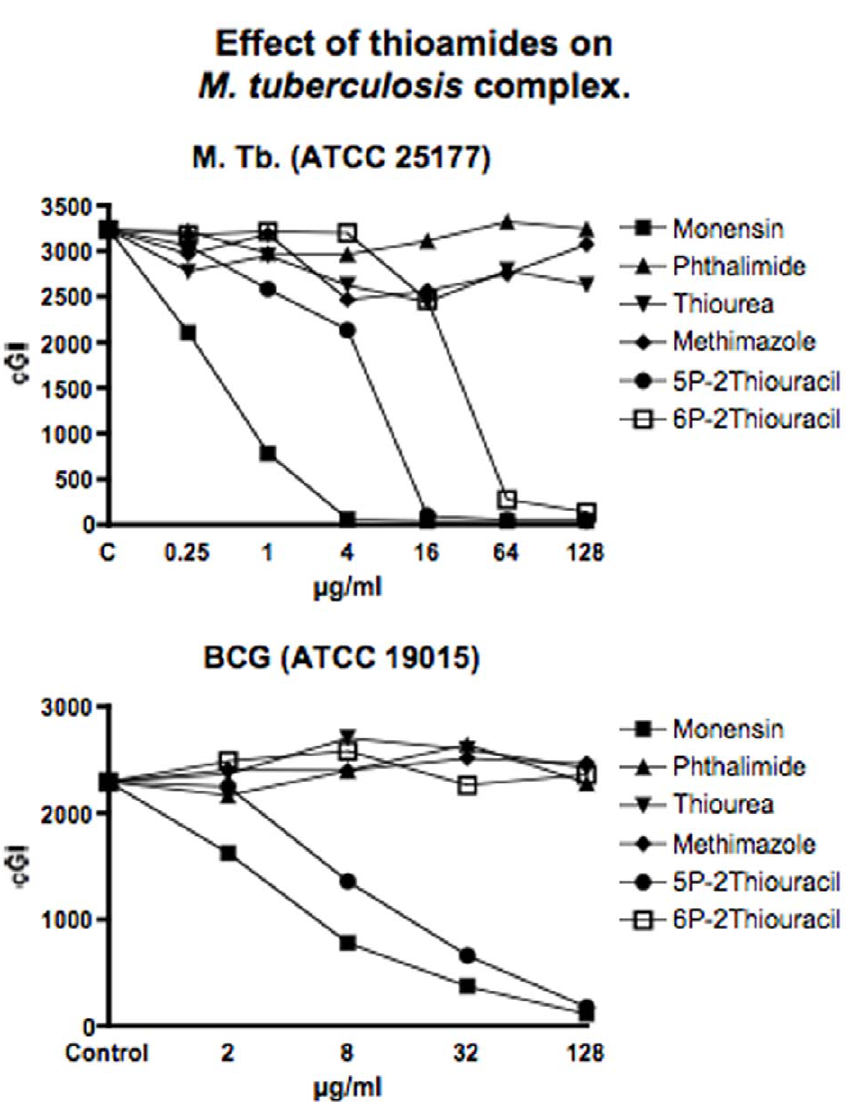
M. avium (Table 4 & Figure 3) or M. tb complex (Table 4 & Figure